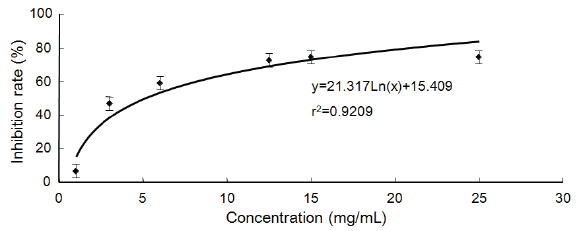
Figure 2: Inhibition curves of different concentrations of EtOAc fraction to FXa.